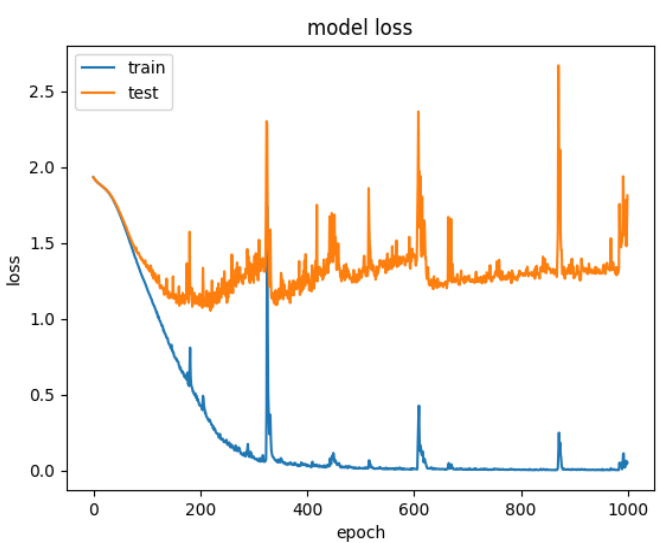
Figure 16. Model loss for CNN+LSTM+Global-Attention+LSTM.